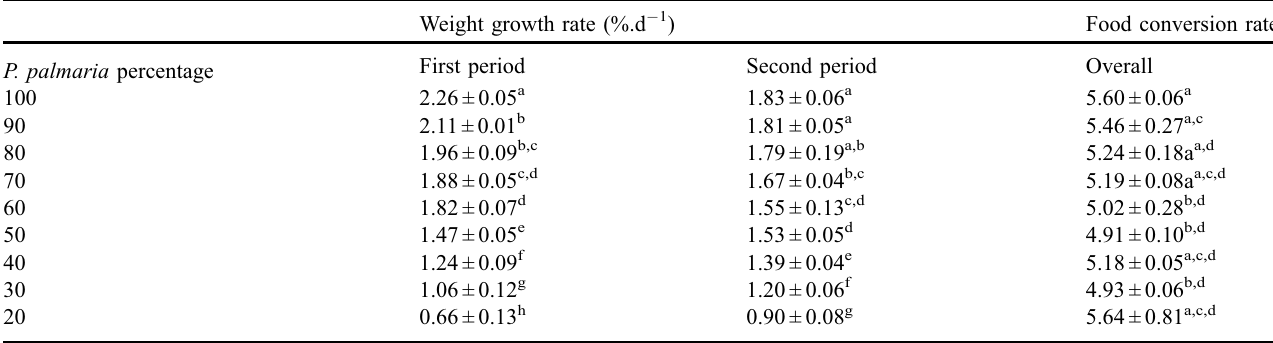
Table 6. Mean and con fi dence intervals ( a = 0.05) of the rate of increase for weight (% d (cid:3) 1 ) bytesting period according to the food ration ( P. palmaria ) (experimentation E5). For each period, diets that do not share a letter signi fi cantly differ (ANOVA and SNK, p < 0.05). Weight growth rate (%.d (cid:3) 1 )